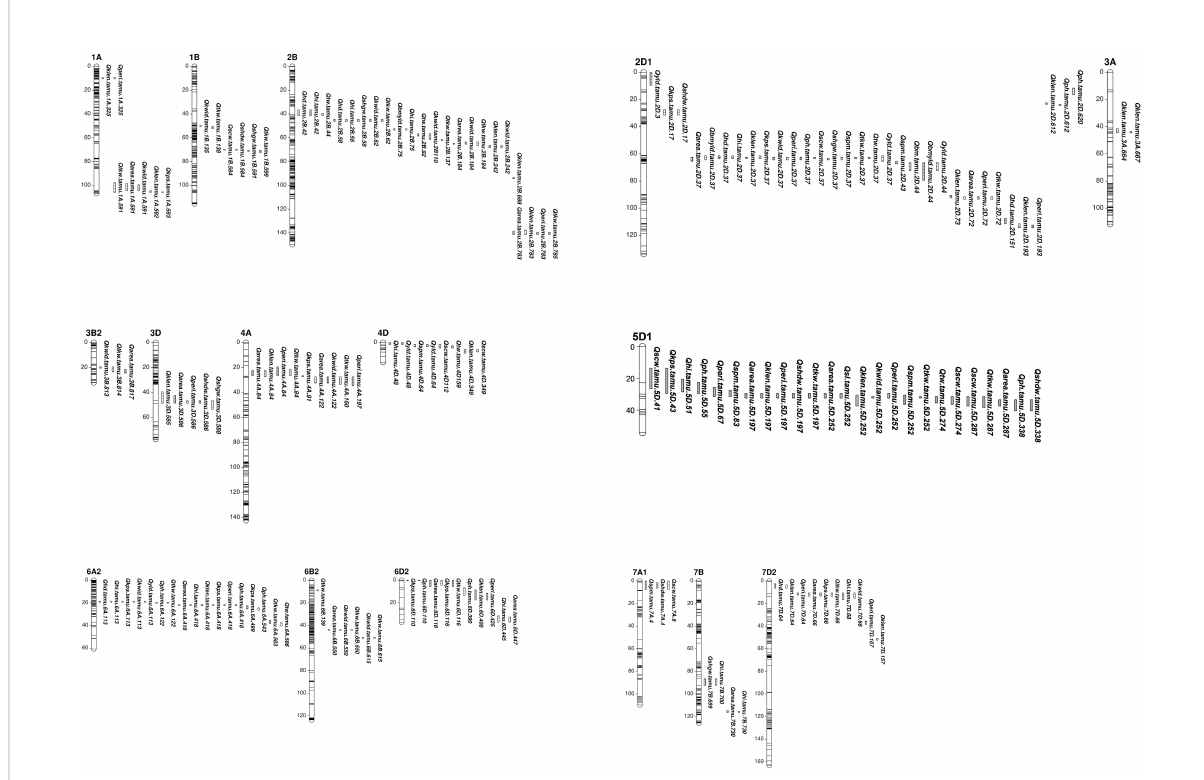
FIGURE 1 Consistent and pleiotropic QTL for yield related, agronomy and kernel traits identi fi ed with TAM112/Duster population by individual and multiple environment analysis. Traits include: 1) grain yield from whole plot (YLD, g m -2 ); 2) dry weight of biomass sample (BM, g m -2 ); 3) grain yield from biomass sample (BMYLD, g m -2 ); 4) test weight (TW, Kg m -3 ); 5) harvest index (HI, %); 6) kernel spike -1 (KPS, kernel spike -1 ); 7) spike m -2 (SPM, spike m -2 ); 8) thousand kernel weight (TKW, g); 9) single head dry weight (SHDW, mg); 10) single head grain weight (SHGW, mg); 11) single culm weight (SCW, g); 12) kernel area (AREA, mm 2 ); 13) kernel perimeter (PERI, mm); 14) kernel length (KLEN, mm); 15) kernel width (KWID, mm); 16) spike length (SL, cm); 17) heading date (HD, days); 18) plant height (PH,